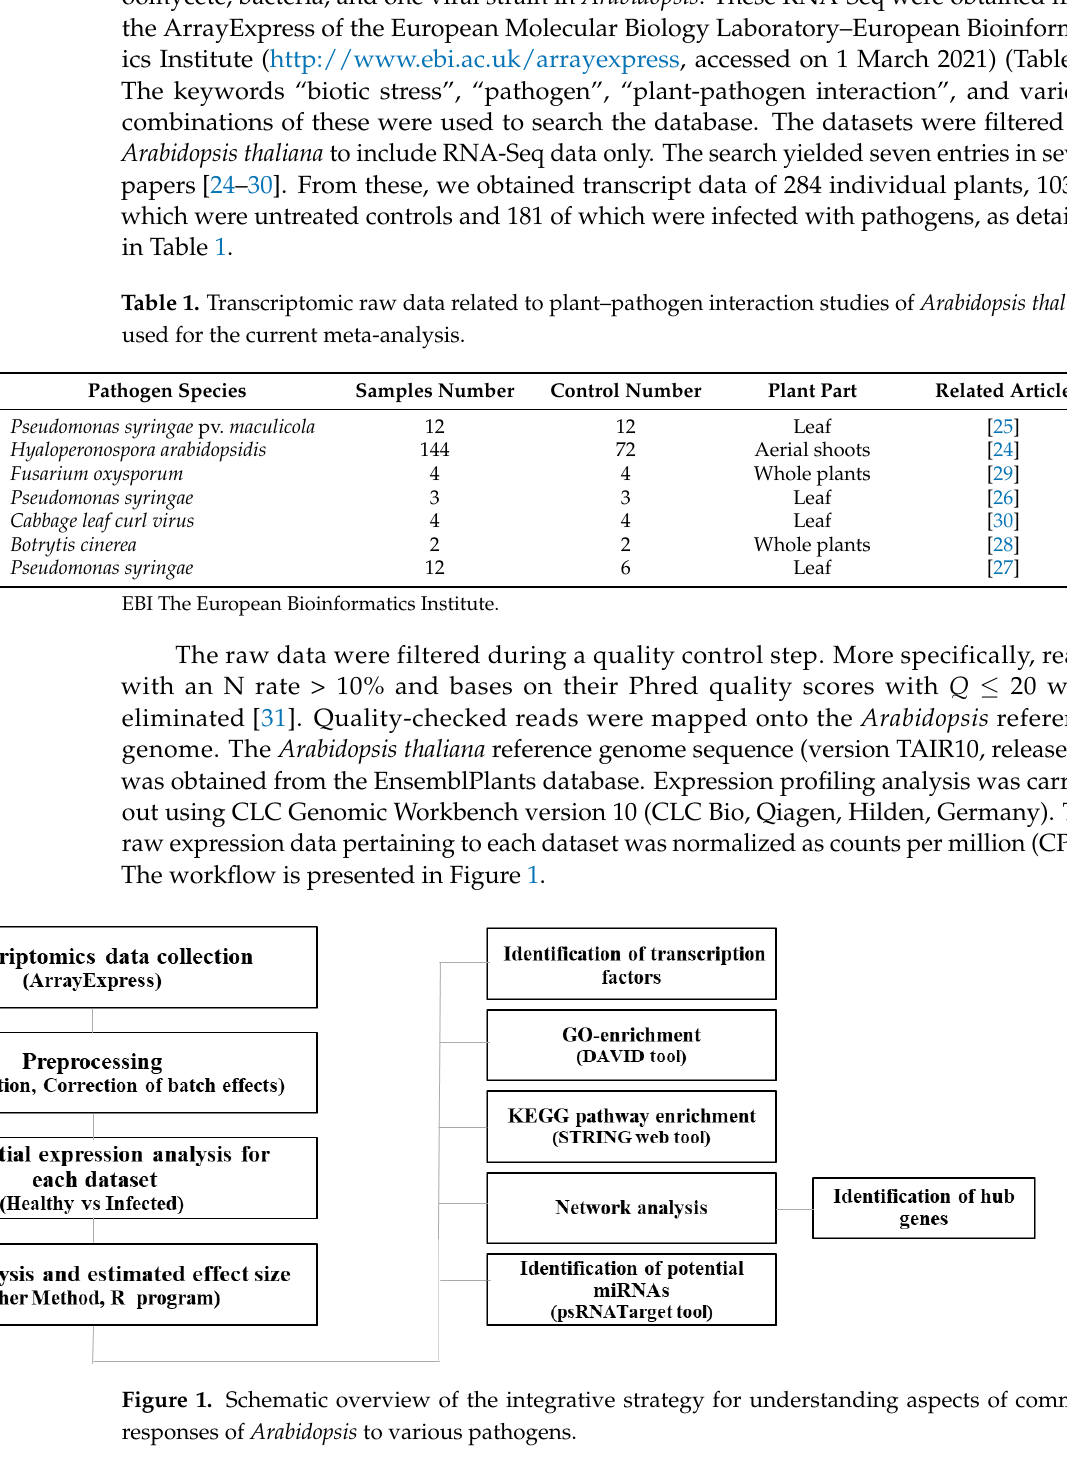
Figure 1. Schematic overview of the integrative strategy for understanding aspects of common re- sponses of Arabidopsis to various